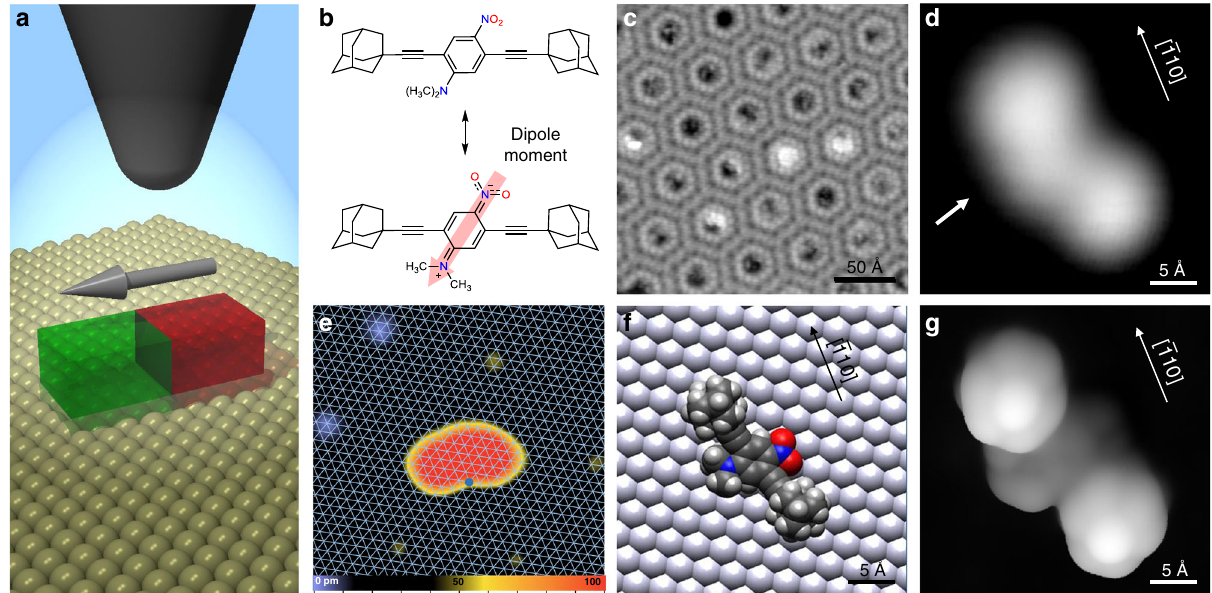
Fig. 1 Adsorption of polar DDNB molecules on Ag(111). a Scheme of the experimental setup. b Chemical structures of DDNB showing the permanent net dipole moment from the negatively charged – NO 2 to the positively charged -N(CH 3 ) 2 groups. c STM image (1.03 V, 0.76 pA) of highly ordered DDNB assemblies on Ag(111) (see Supplementary Fig. 1). d STM image (1.03 V, 0.27 pA) of a single DDNB molecule and e (0.70 V, 0.27 pA) of a larger area with Ag adatoms (yellow) and CO molecules (blue) with respect to the underlying Ag(111) lattice. The pivot point of the molecule is marked by a blue spot. The color scale indicates apparent height. f Calculated adsorption geometry on the Ag(111) surface. g Simulated STM image based on the optimized structure shown in